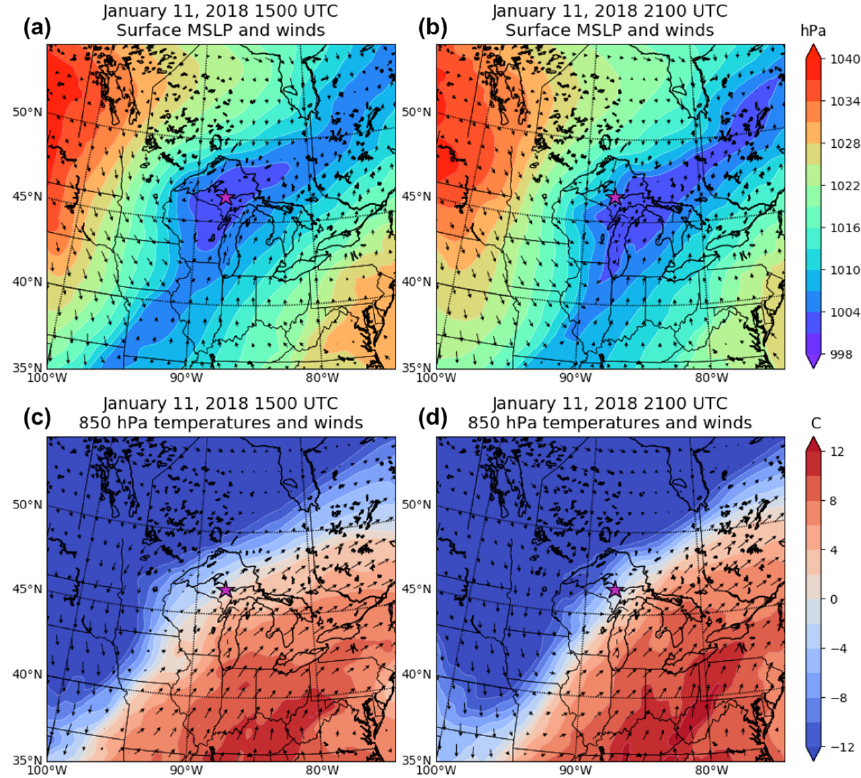
Figure 4. ERA5 MSLP and surface winds and 850 hPa temperatures and winds for 11 January 2018 at 1500 ( a , c ) and 2100 UTC ( b , d ). The purple star denotes the location of NWS MQT. The second event also exhibits a transition from rain to snowfall, however with a longer period of rain and several key profile changes as the rain evolves before switching to snowfall. This rain-to-snow event occurred on 21 November 2019 and was approximately 14 h in duration (Figure 5). The PIP and the NWS MQT observed rain beginning at 0940 UTC and ending around 1650–1700 UTC, with snowfall onset at 1650 UTC. The precipitation transition is identified in the PIP estimates of density in Figure 5d where the red (rain) transitions to blue (snow). The PIP PSDs exhibit generally small particles and narrow width during the rain period, while after the transition to snow, the PIP PSDs are broader and contain larger particles. There is again very good agreement between the PIP and the Parsivel (Figure 5d, dots) for the precipitation phase transition at 1650 UTC. Similar to the previous event, there are distinct melting layer and rain signatures in the MRR profile observations. There is evidence of a bright band and enhanced reflectivities (>25 dBZ) in the lowest ~2 km AGL from the onset of the rain to ~1300 UTC, at which point the layer of enhanced reflectivities becomes very shallow (<1 km) and continues to taper until disappearing entirely at 1650 UTC (Figure 5a). The profiles of MRR Doppler velocity show higher fall speeds in the same period as the enhanced reflectivities (Figure 5b), indicating that the precipitation is rain. This rain period coincides with the timing of rainfall indicated by the PIP. The profiles of temperature from the ERA5 reanalysis denote a much deeper layer of warm temperatures (>0 ◦ C) extending to almost 700 hPa through 1400 UTC. The 0 ◦ C isotherm then starts to slowly descend reaching 925 hPa at 1800 UTC (Figure 5f), after the onset of the snowfall, at which point the temperatures above the 925 hPa level are below freezing. The profile observations from the MRR and the ERA5 reanalysis are consistent with the observations and timing of the transition of rain to snowfall seen by the